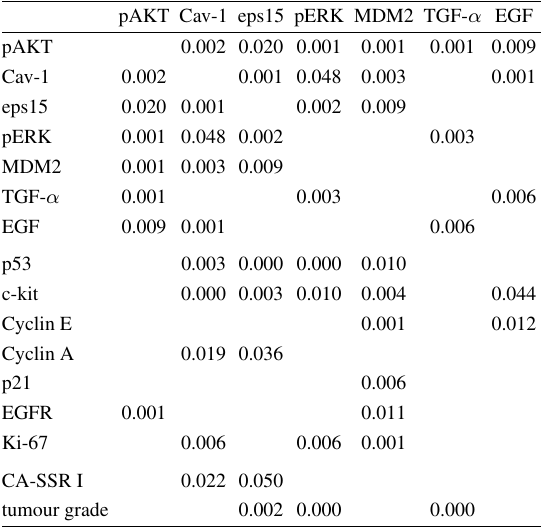
Overview about the significance of found immunohistochemical correlations